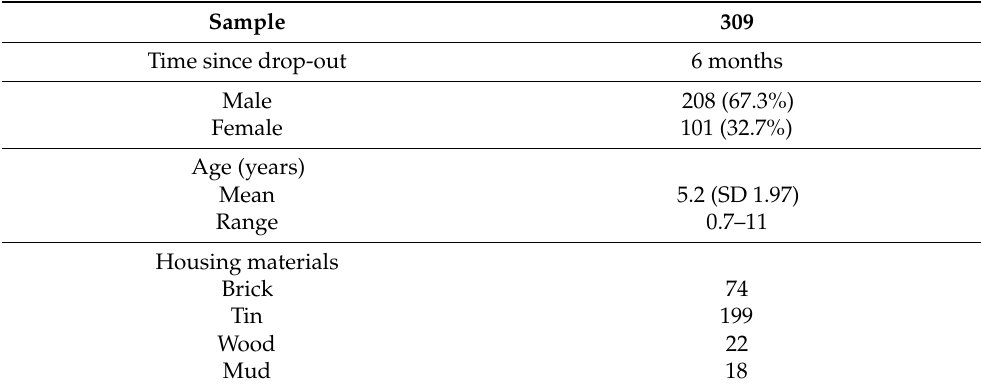
Table 1. Demographic data from the community